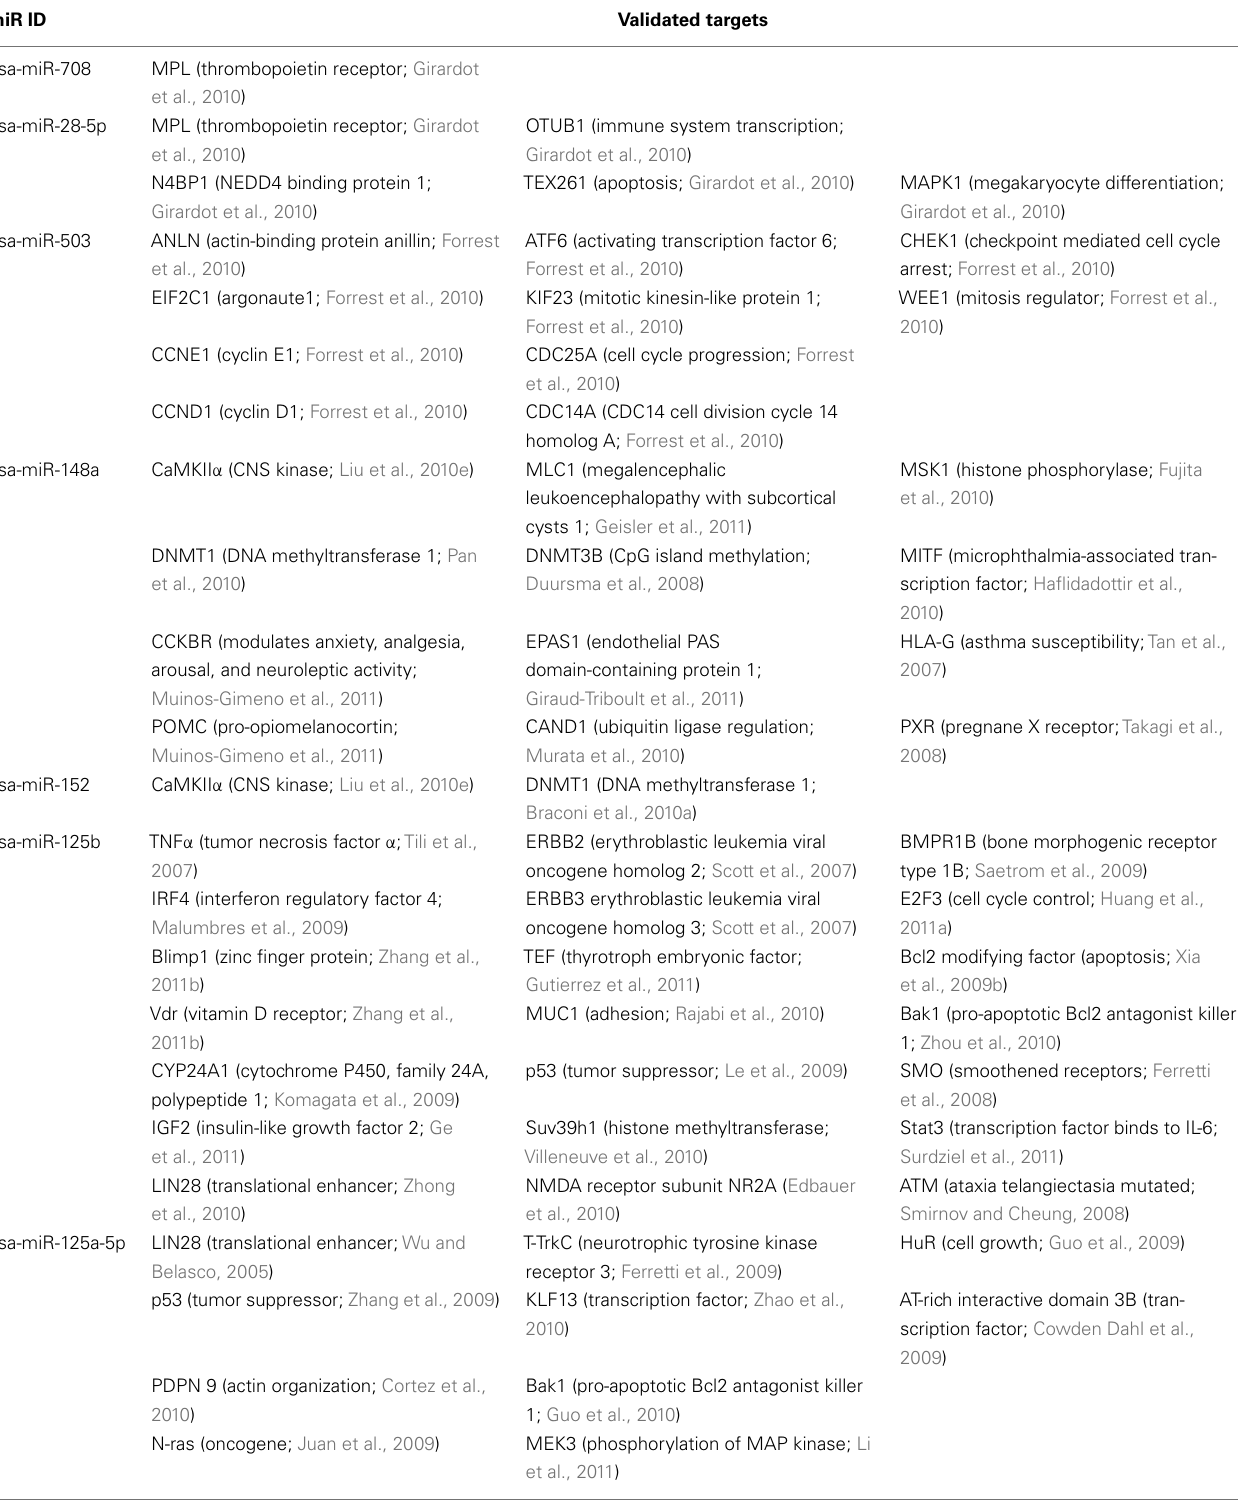
TableA2 |Additional targets of microRNAs